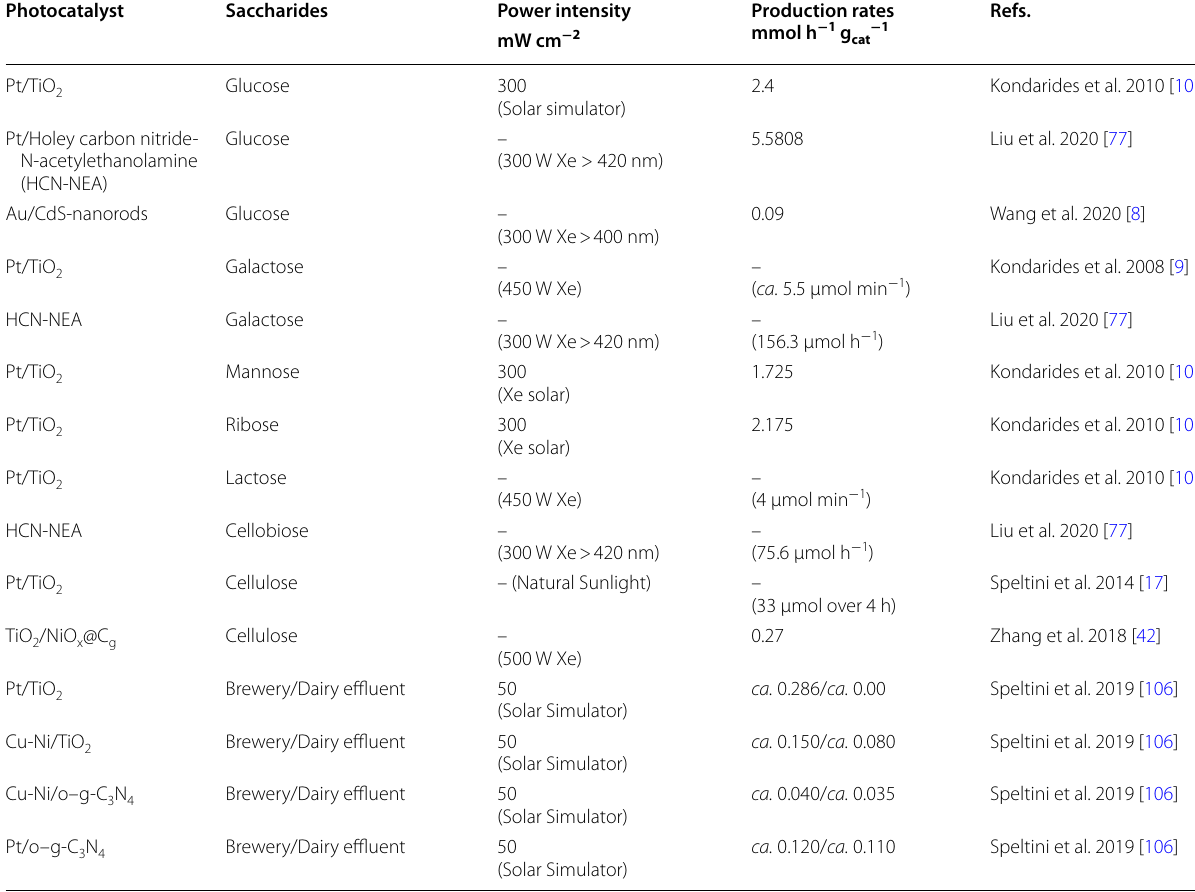
Table 2 Photocatalytic hydrogen production from saccharides using visible light sources